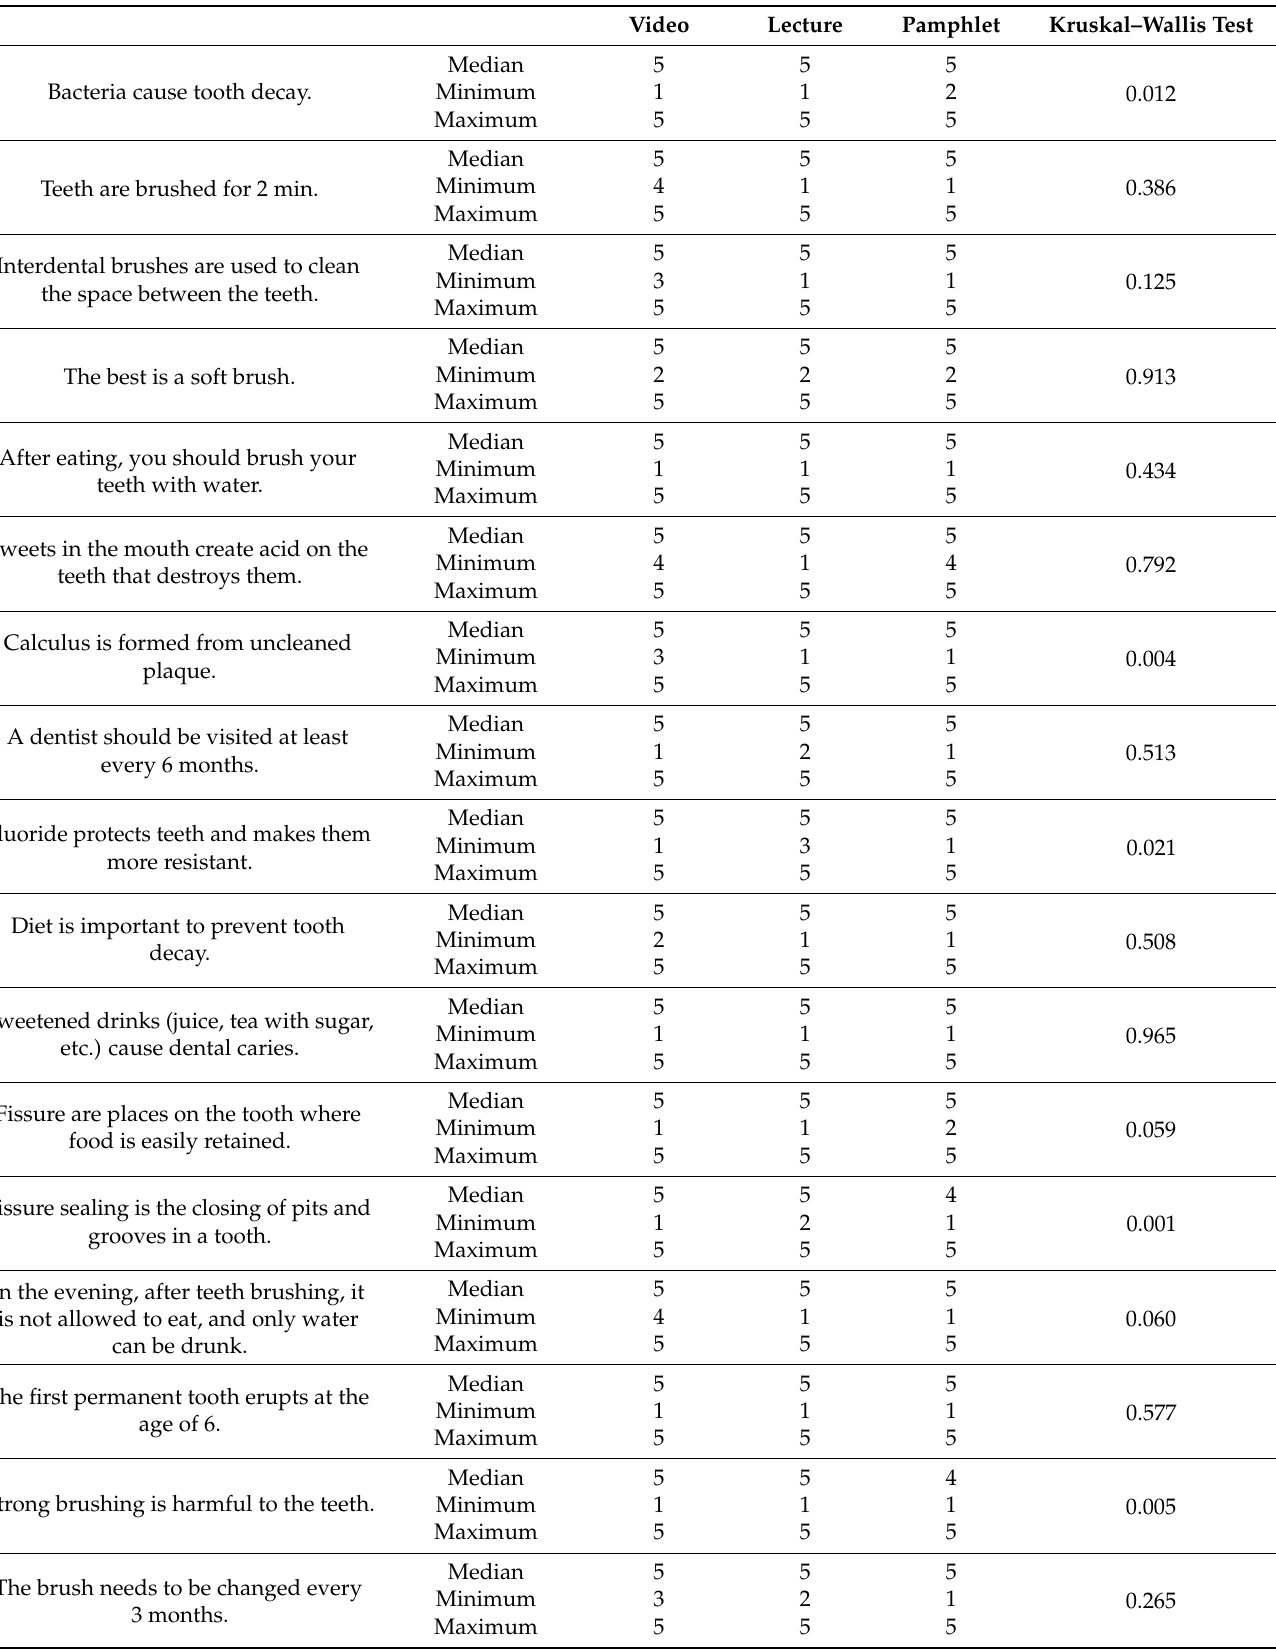
Table 2. The distribution of answers after education, observing three forms of teaching (video, lecture, and pamphlet). Video Lecture Pamphlet Kruskal–Wallis Test Median Bacteria cause tooth decay. Maximum Teeth are brushed for 2